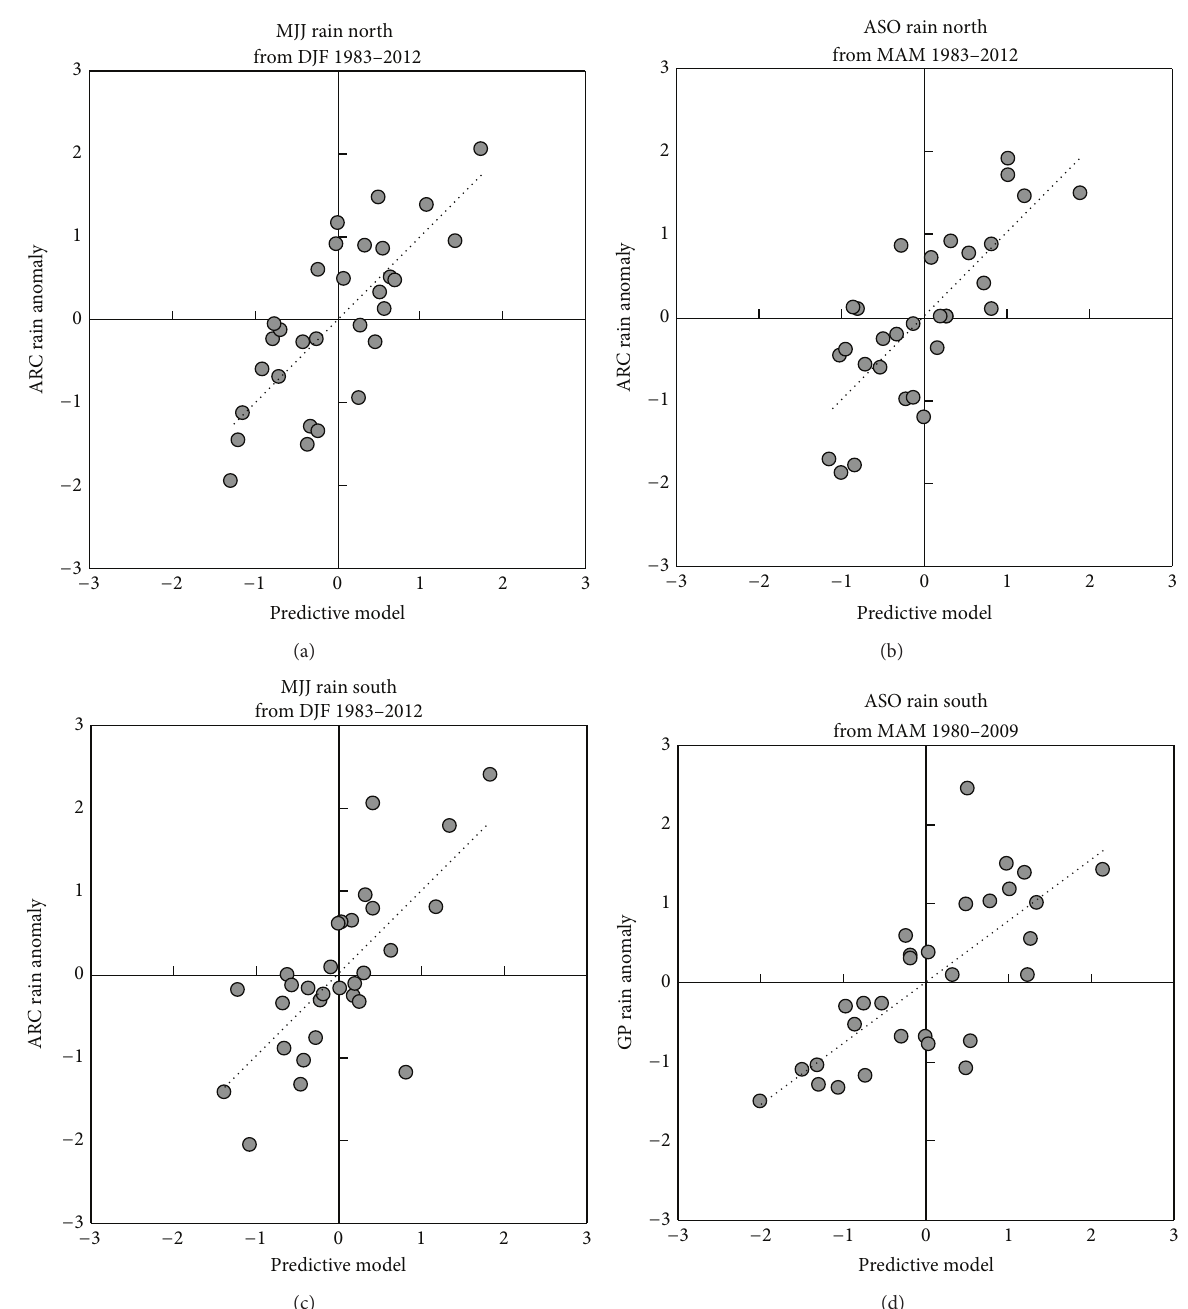
Figure 7: Scatterplots of predicted and observed rainfall according to Table 1(a). Southern ASO represented by GPCC6 rain; others are ARC2. Linear regression lines are